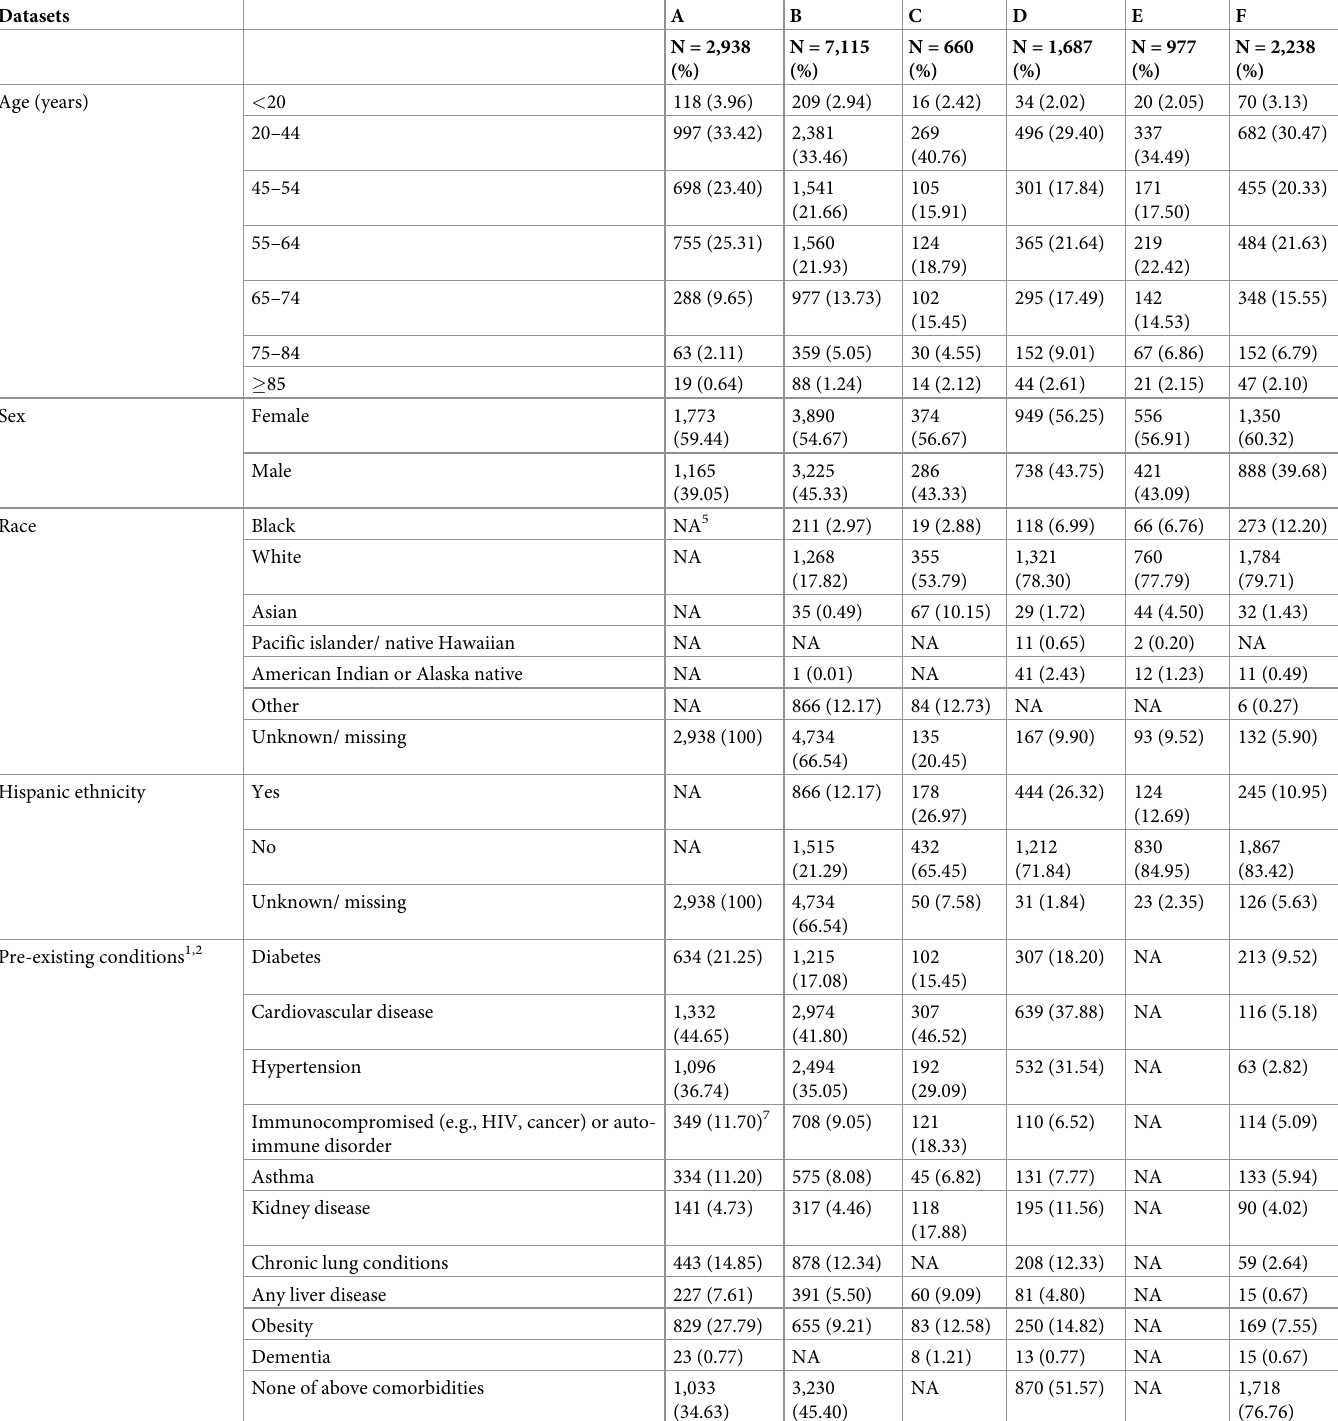
Table 1. Clinical and demographic characteristics of patients with positive RNA and who underwent serological tests.